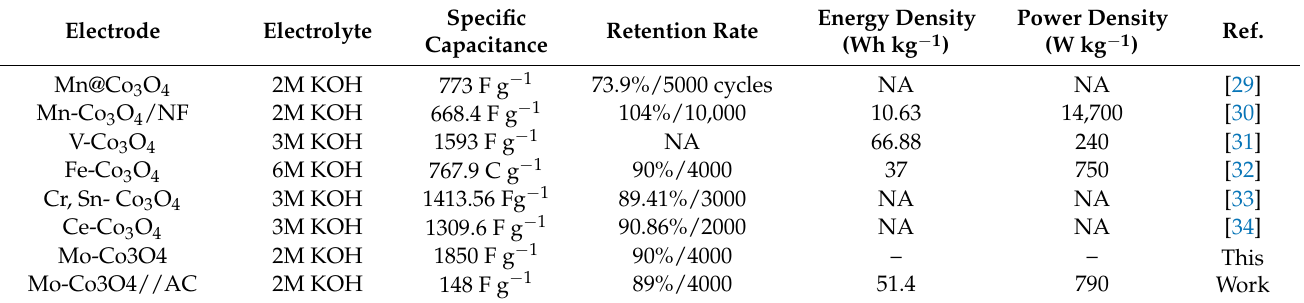
Table 3. Various electrochemical properties of Co 3 O 4 -related materials compared to previous